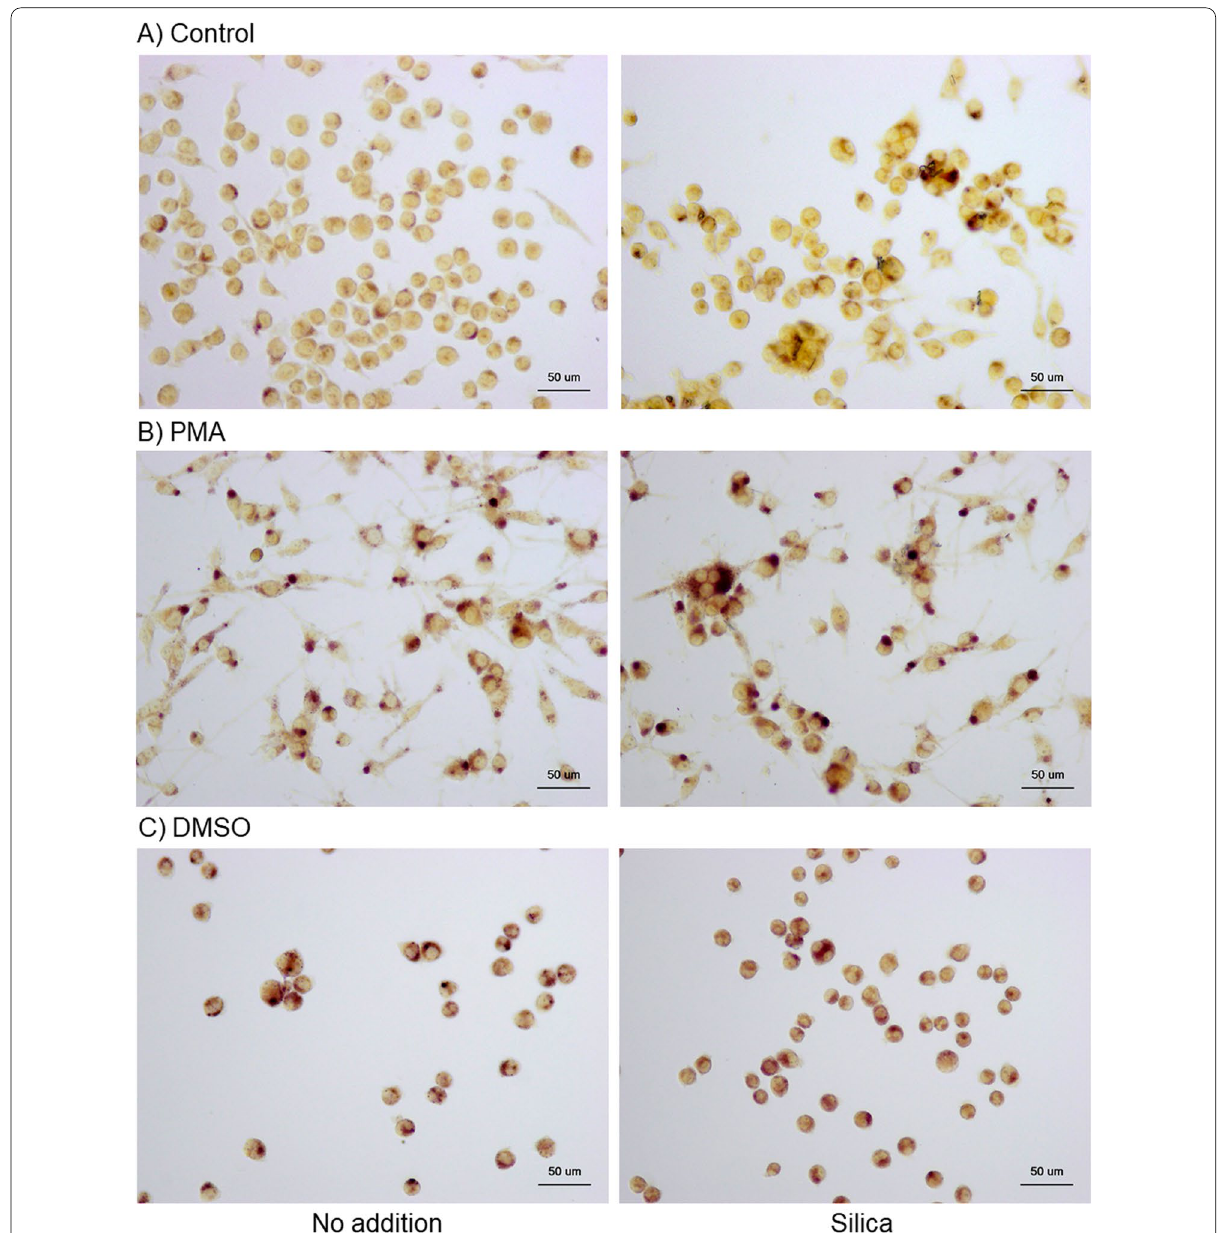
Fig. 5 Effects of silica microparticles (MPs) on non-specific esterase (NSE) activity in control A and phorbol 12-myristate 13-acetate (PMA)- B and dimethyl sulfoxide (DMSO)-treated HL60 cells ( C ). These cells were simultaneously treated with silica MPs for 3 days. The cells were then fixed and subjected to cytochemical NSE staining. Similar data were obtained from two additional independent experiments ( n